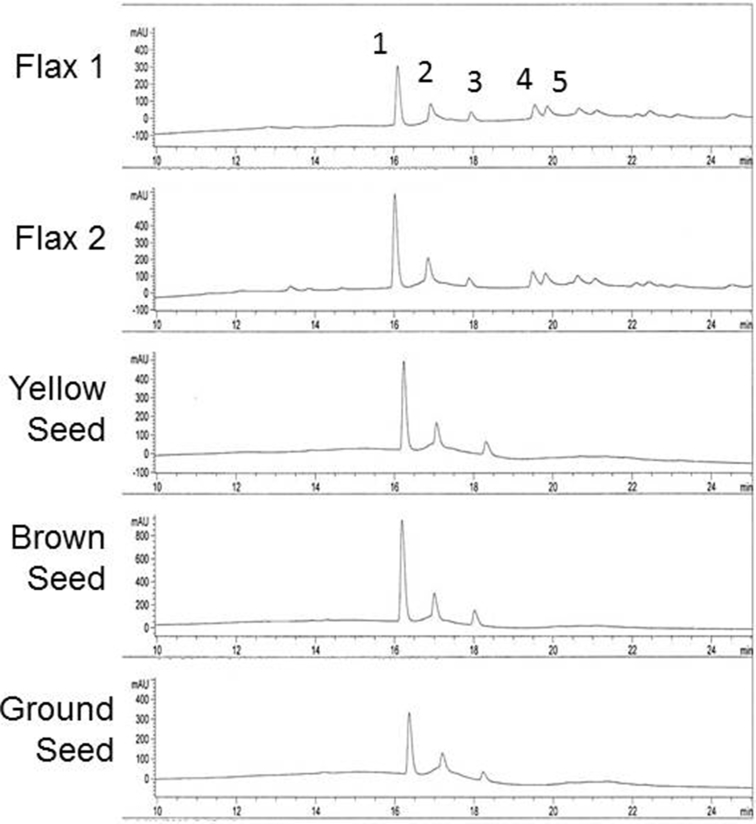
HPLC chromatograms of different oils used in these experiments. Fatty acids were extracted from flaxseed oil from different sources and methylated prior to analysis by HPLC. The identity of each peak was determined by comparison to a FAME standard. 1. α-linolenic acid; 2. linolenic acid; 3. oleic acid; 4. palmitic acid; 5. stearic acid.